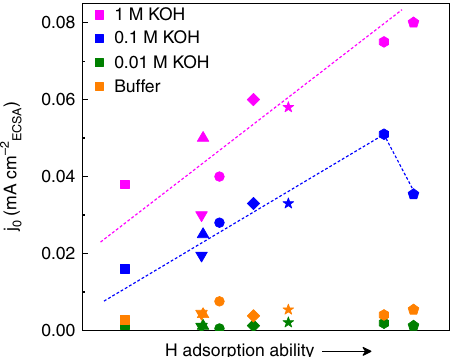
Fig. 2 The experimentally acquired relationship between the H adsorption ability and the activity ( j 0 ) for a series of Pt-based materials using different electrolytes. The symbols in the fi gure are circle: Pt/C; square: PtFe/C; standing triangle: PtCo@Pt/C; inverted triangle: PtCo/C; diamond: PtNi/C; star: PtFe@Pt/C; pentagon: dealloyed PtNi/C; hexagon: PtNi@Pt/C. The H adsorption ability of the electrocatalysts is represented according to the d-band vacancies of each